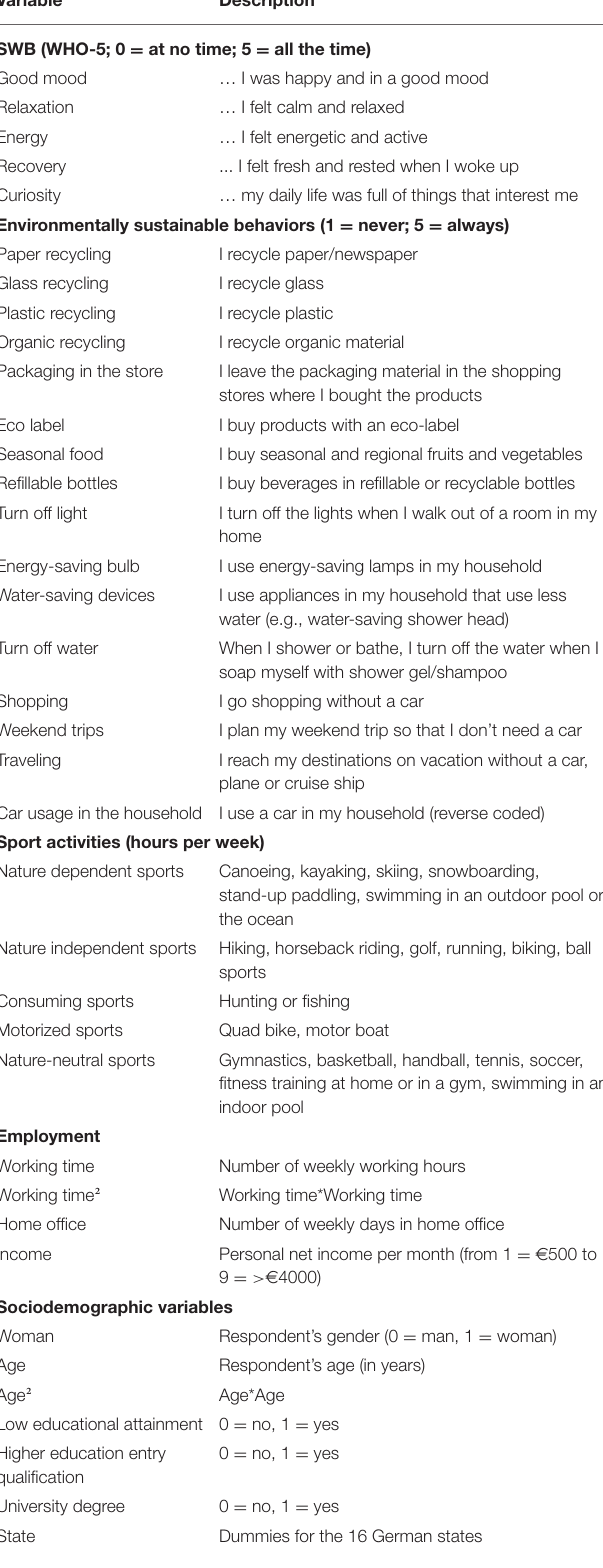
TABLE 1 | Overview of variables. Variable